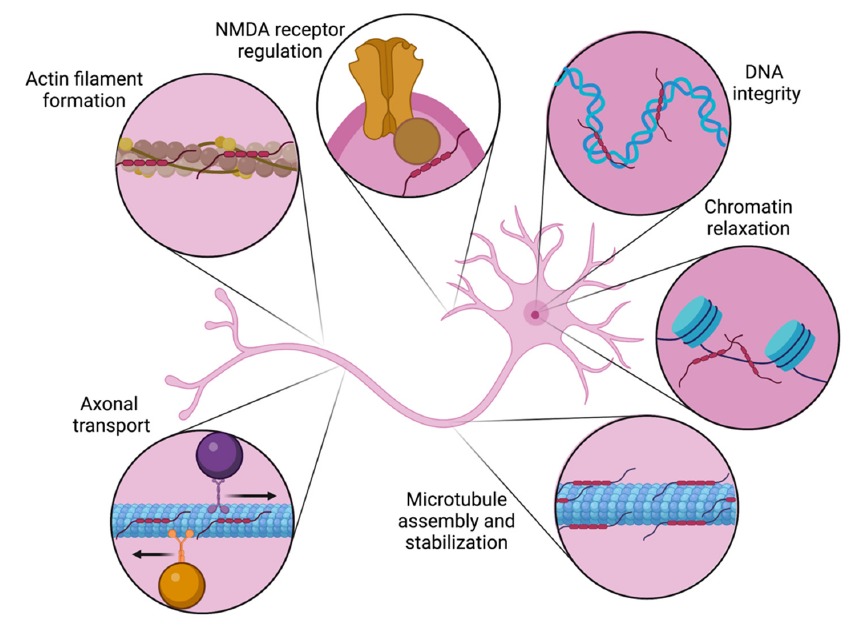
Figure 2. Tau’s diverse physiological roles in the neuron. Initially characterized as a protein required for microtubule assembly and stabilization, it is now recognized that tau has roles in multiple neuronal compartments. Along the axon, tau is involved regulating in bidirectional transport as well as actin filament formation. Nuclear roles include protecting DNA integrity and promoting chromatin relaxation. At the neuronal membrane, tau’s interactions with the NMDA receptor regulate its